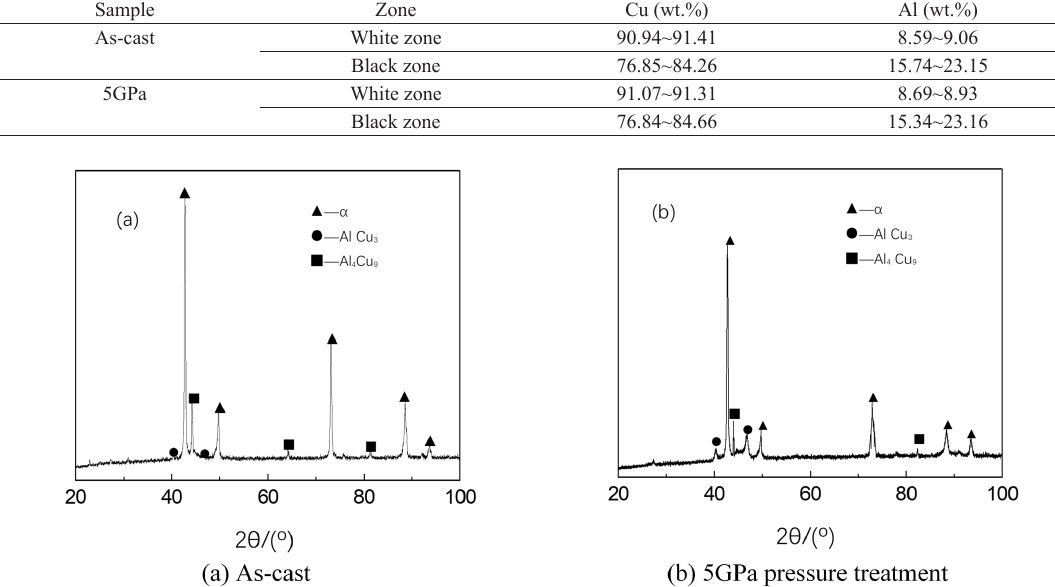
Table 1 - Micro-zone composition analyses of Cu-Al alloy before and after high pressure treatment. Sample